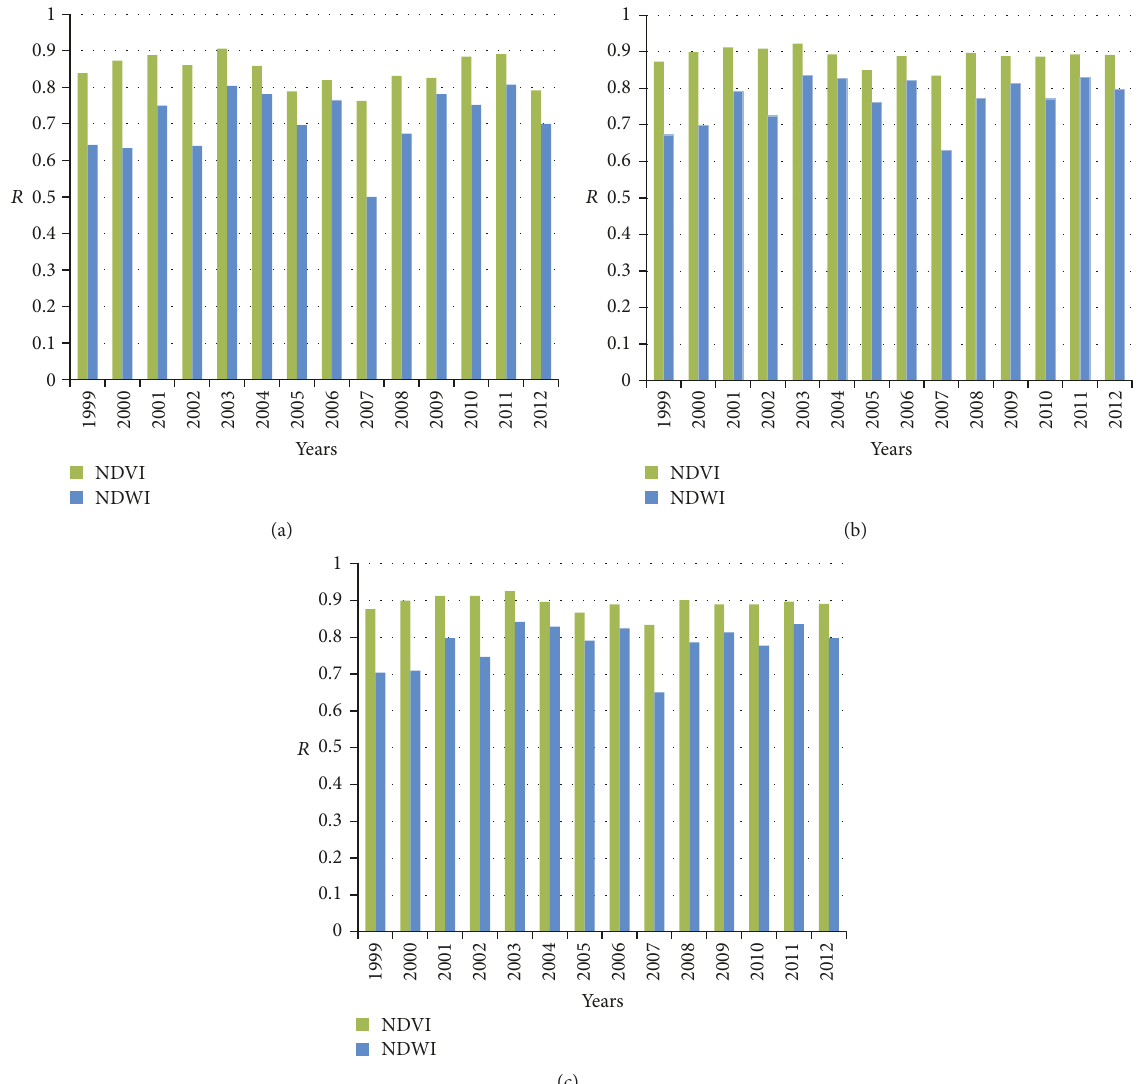
Figure 4: Correlation coefficients between TRMM and explanatory variables: (a) TRMM versus NDVI compared with TRMM versus NDWI, (b) TRMM versus NDVI and elevation compared with TRMM versus NDWI and elevation, and (c) TRMM versus NDVI, elevation, and distance compared with TRMM versus NDWI, elevation, and